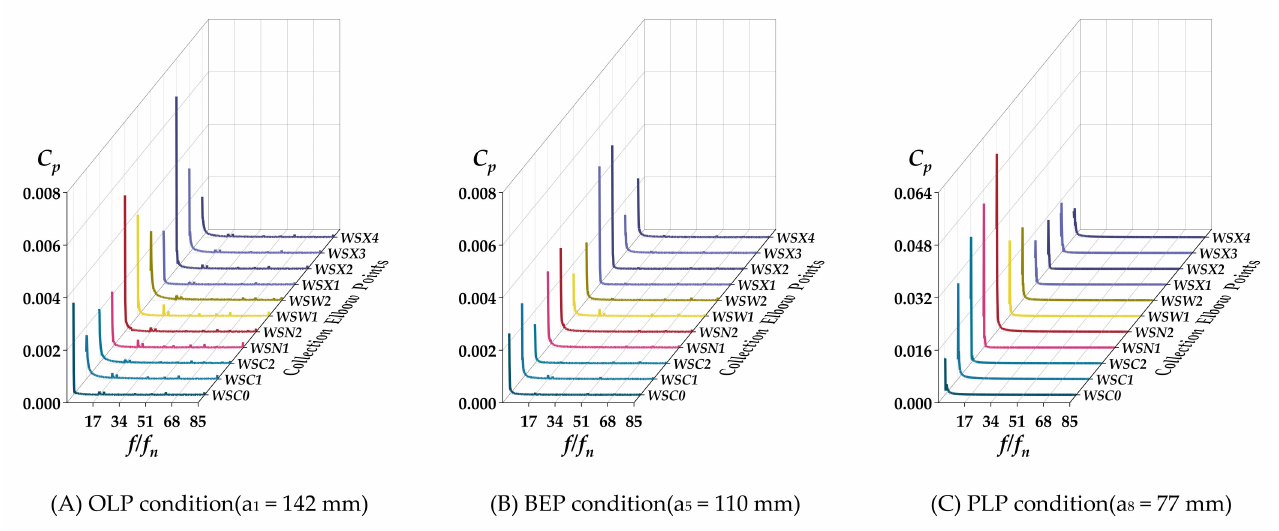
Figure 20. Spectrum of pressure pulsation at the collection elbow monitoring point under different working